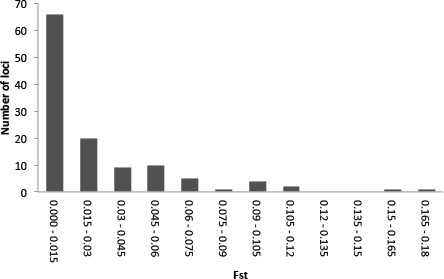
Frequency distribution of per-locus pairwise (Prunus–Sorbus) \documentclass[12pt]{minimal}
\usepackage{amsmath}
\usepackage{wasysym}
\usepackage{amsfonts}
\usepackage{amssymb}
\usepackage{amsbsy}
\usepackage{upgreek}
\usepackage{mathrsfs}
\setlength{\oddsidemargin}{-69pt}
\begin{document}
}{}${F}_{\mathrm{ST}}$\end{document}FST values for Gonioctena quinquepunctata.